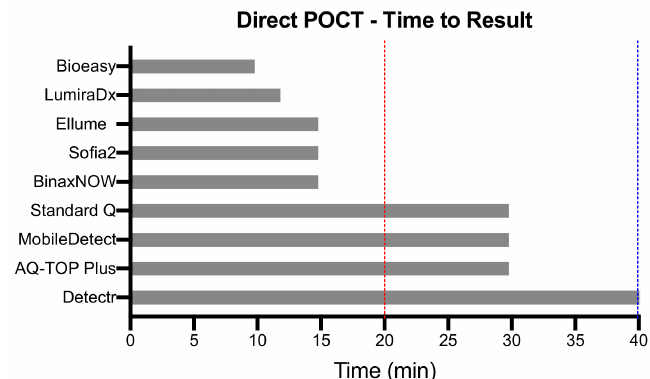
Figure 4. Time to result of selected direct POCTs. The time to result of direct (antigen/RNA) POCTs that met the WHO “desirable” clinical sensitivity criteria (see Figure 2) based on manufacturer’s claims. Blue and red lines represent WHO TPP “acceptable” and “desirable” thresholds,